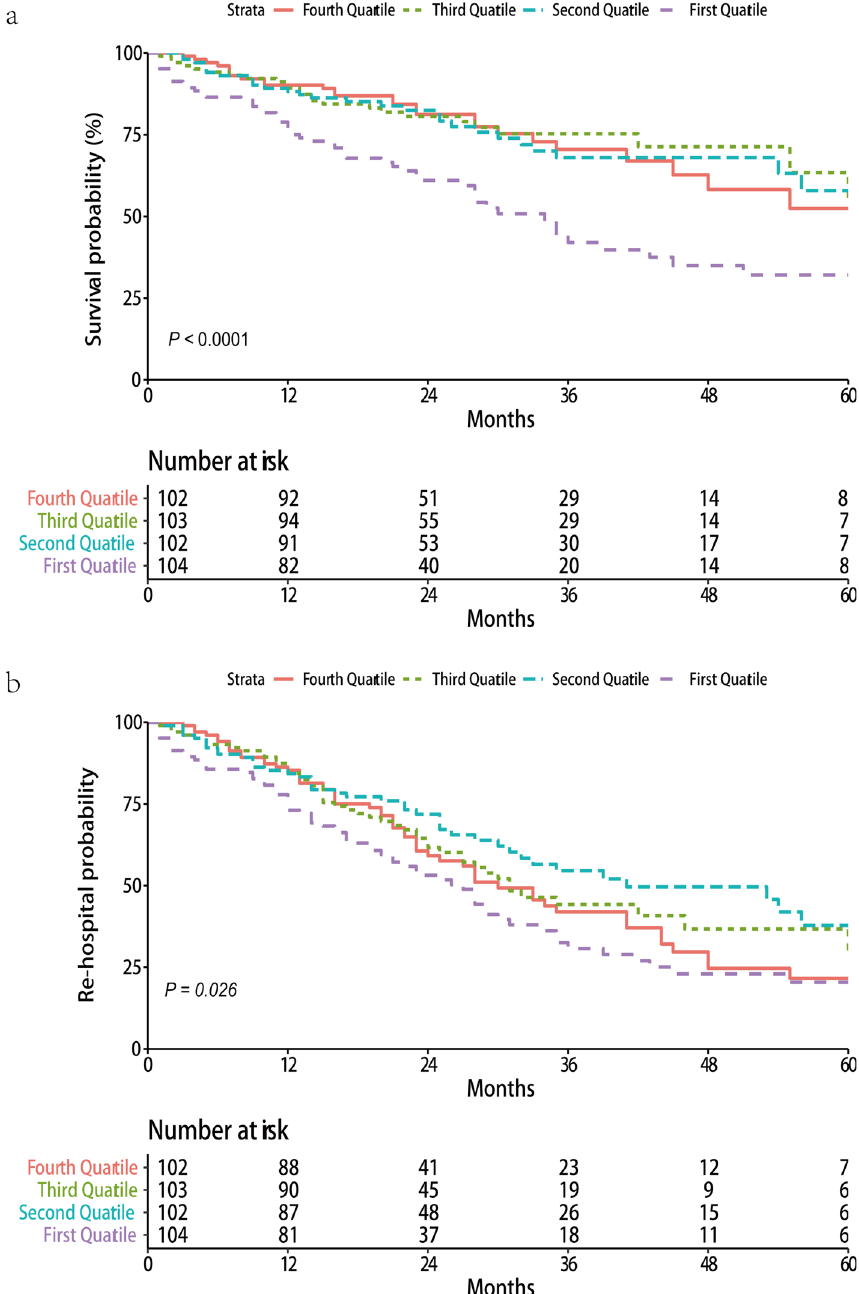
Figure 1. Kaplan–Meier survival curve for all-cause mortality ( a ) and rehospitalization ( b ) among patients with heart